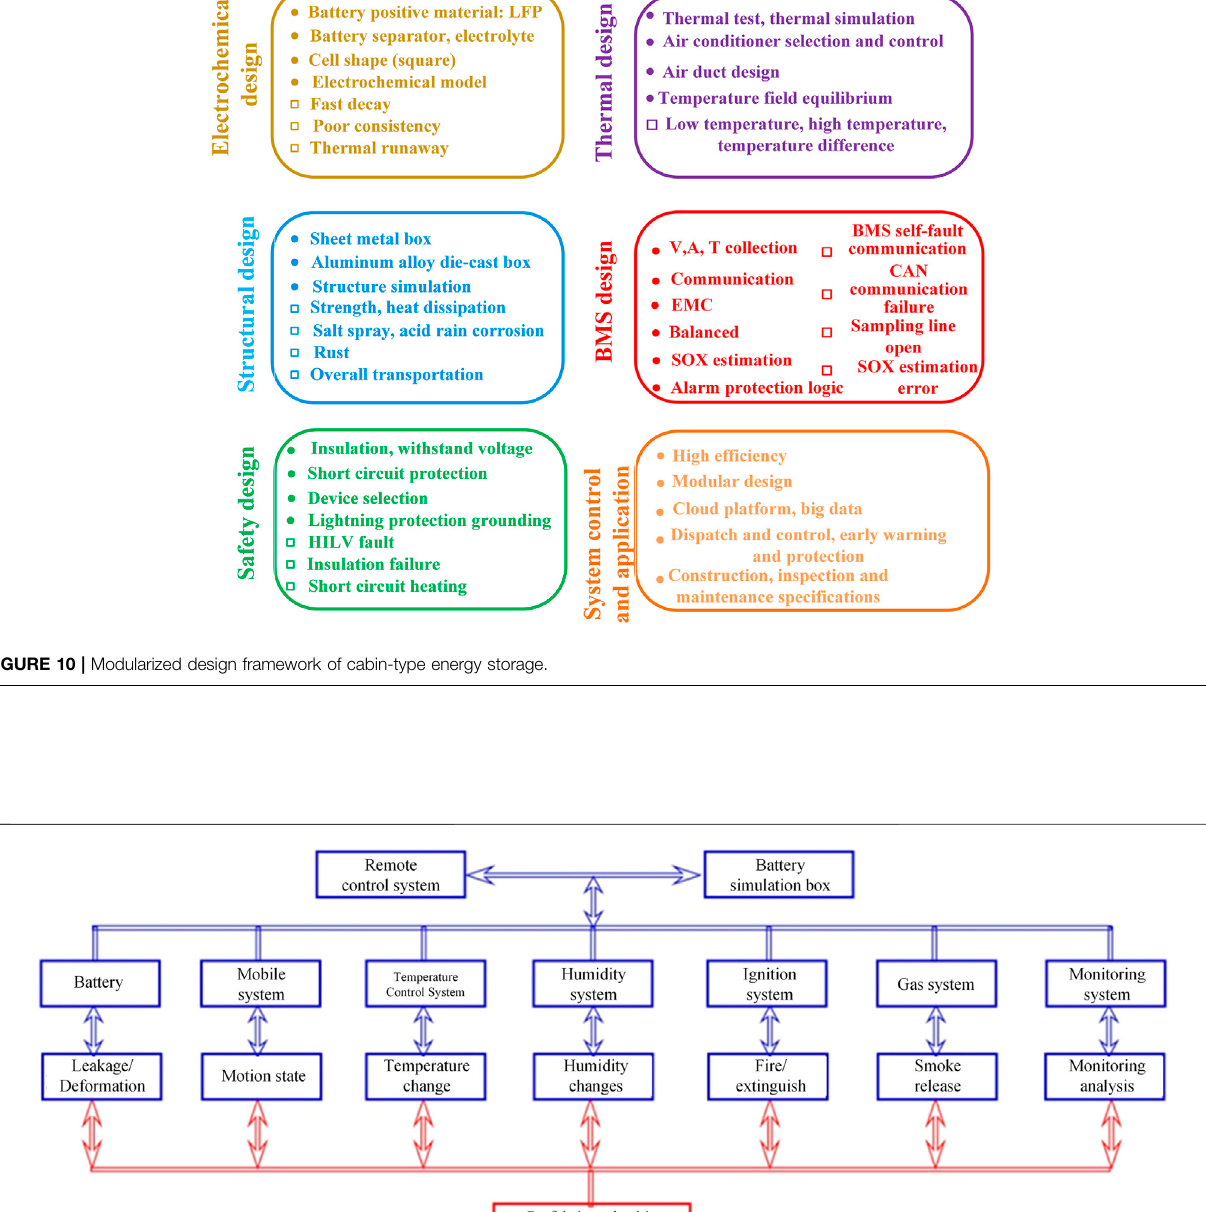
Frontiers in Energy Research |